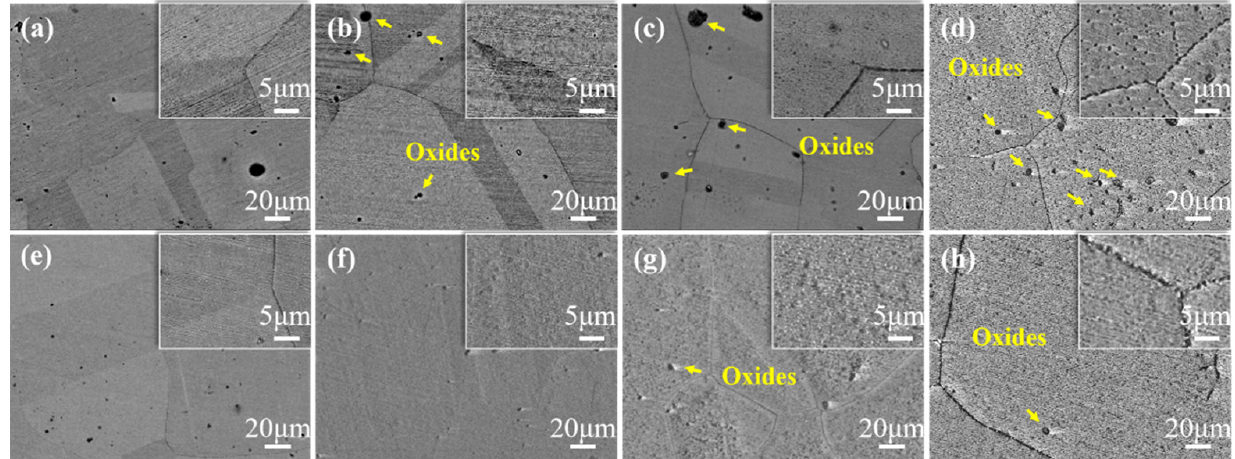
Figure 2. The SEM surface morphologies of the 254SMO–0B ( a–d ) and 254SMO–40B ( e–h ) samples after oxidation at 900 °C for 3min, 6min, 9min, 30min.